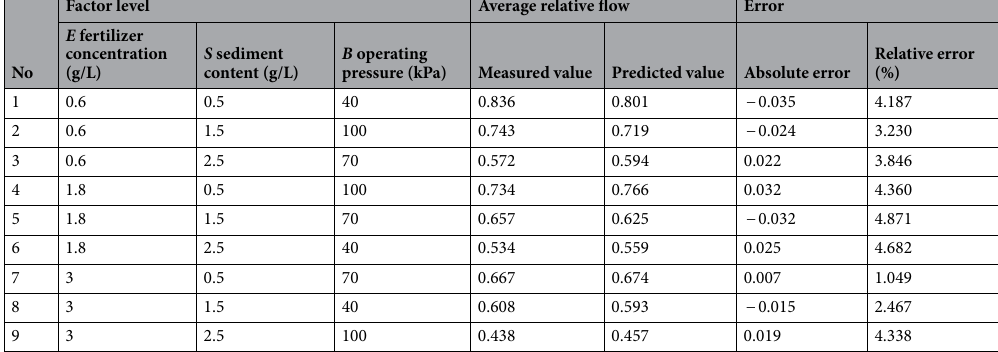
Table 7. Comparison of measured and predicted values of average relative flow of testing samples (H1